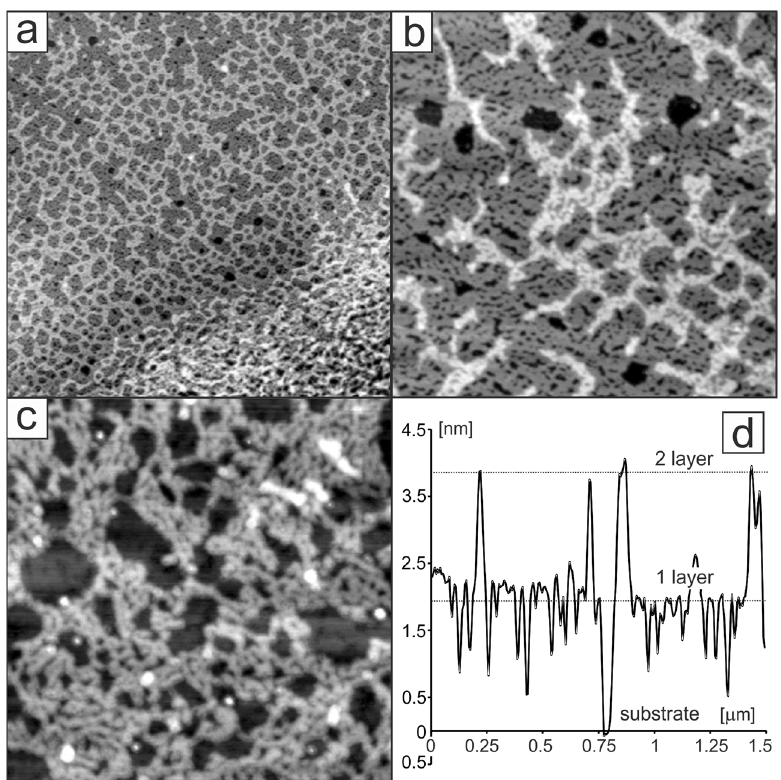
Figure 4. AFM images ( a – c ) and the corresponding line profile ( d ) of mono-, bi-, and multilayers of P5 deposited on mica from its solutions in chlorobenzene. Scanning area: ( a ) multilayer 5 × 5 µ m 2 , ( b ) bilayer 1.5 × 1.5 µ m 2 , ( c ) monolayer 1 × 1 µ m 2 , ( d ) surface profile of selected line from image ( b